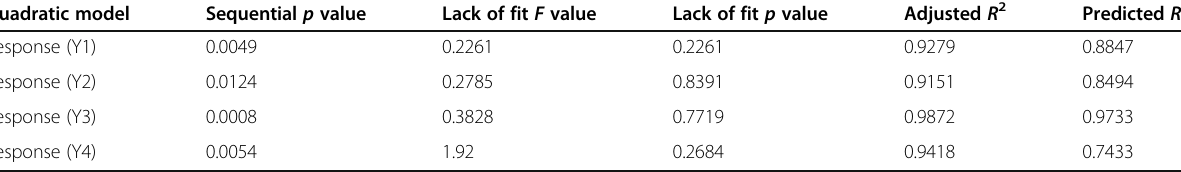
Table 4 Summary of results of regression analysis for responses Y1, Y2, and Y3 for fitting to quadratic model Quadratic